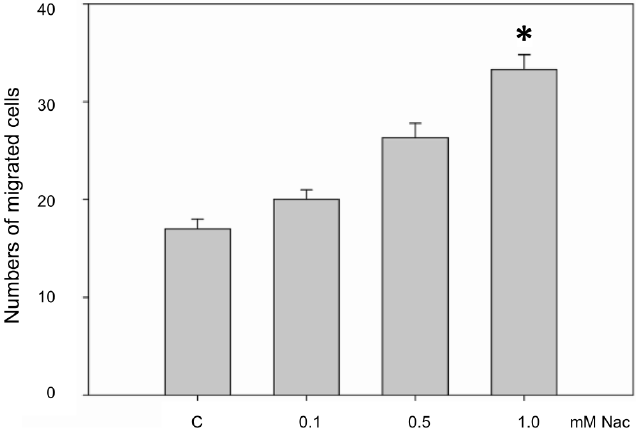
Figure 4. Effect of Nac on migration of CCD-966SK cells. CCD-966SK cells were treated with various concentrations (0–1.0 mM) of Nac for one day. Cell migration was measured in a Transwell assay for 12 h with Millicell (Millipore, Bedford, MA, USA). The migration ability of CCD-966SK cells was quantified by counting the number of cells that invaded the underside of the porous polycarbonate membrane under microscopy, and is represented as the average of three experiments, mean ± SD. * p < 0.01 compared with the untreated